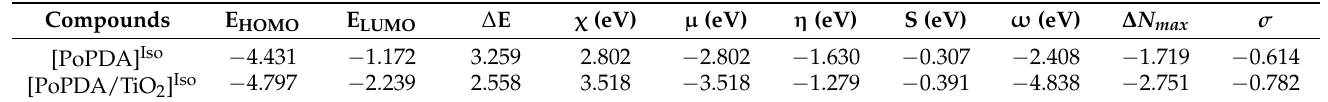
Table 2. Geometry constants for the monomer and dimers [PoPDA] Iso and [PoPDA/TiO 2 ] Iso as isolated molecules.